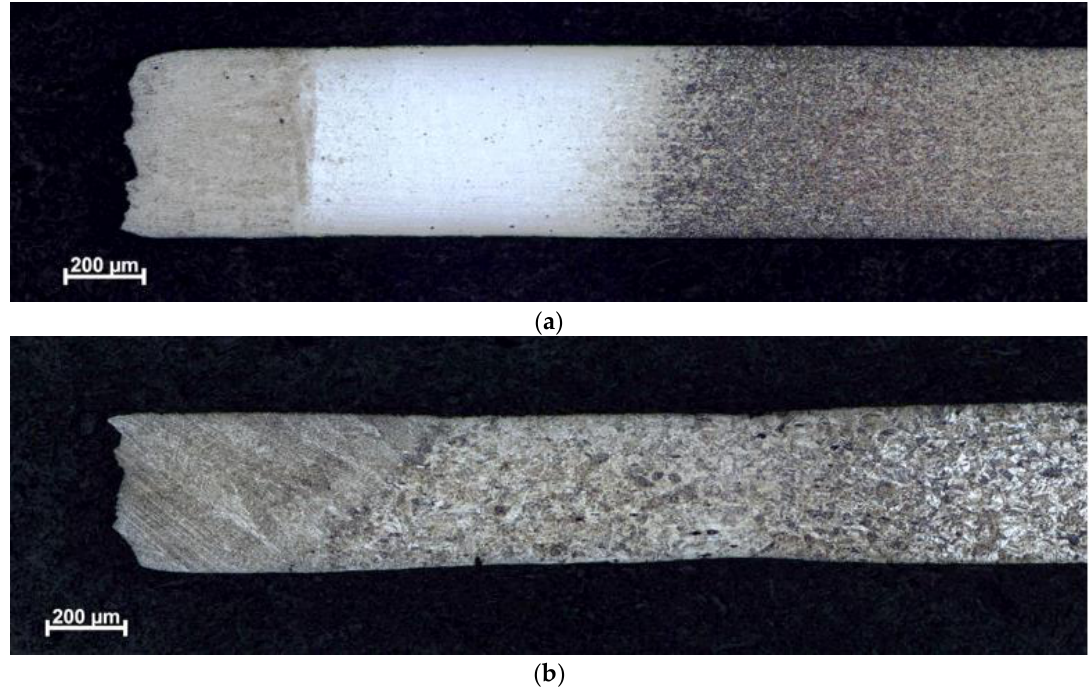
Figure 11. Microstructure on longitudinal sections through miniature tensile test specimens from weld 18 (the fracture is on the left): ( a ) Specimen of the top sheet T15-81c; and, ( b ) Specimen of the bottom sheet T15-82a.